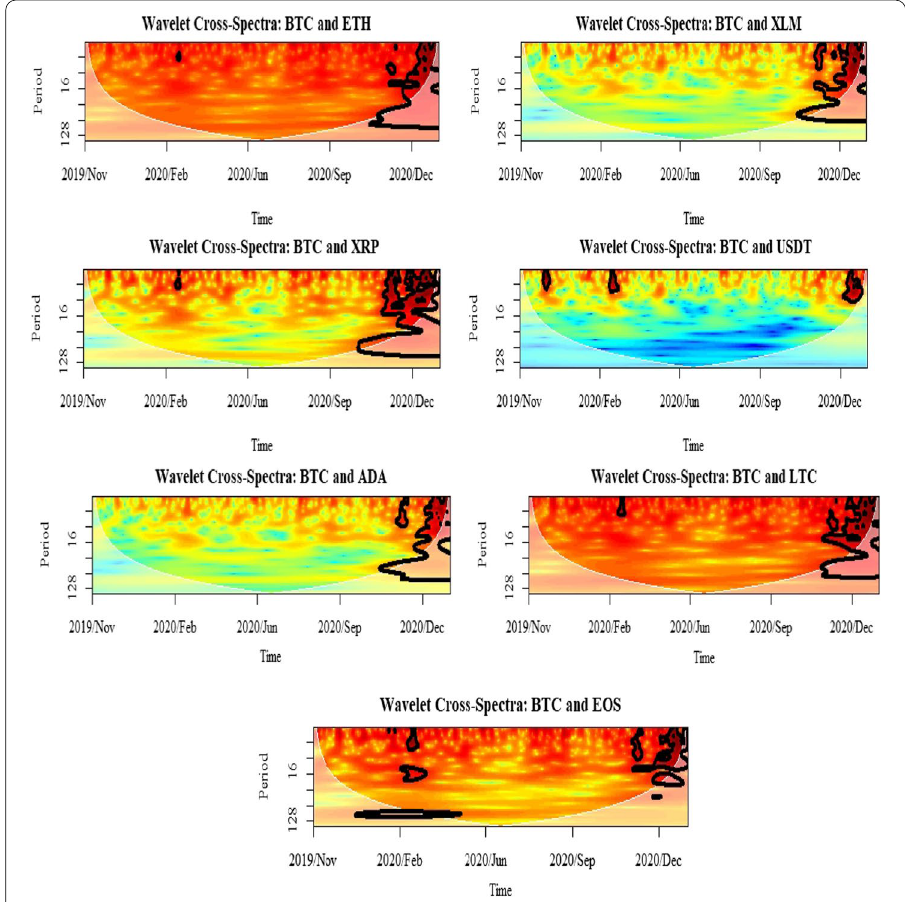
Fig. 9 Results for wavelet cross-spectra: BTC